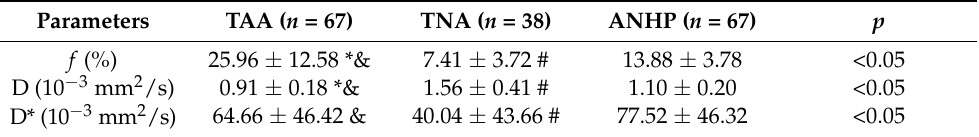
Table 4. The parameter values of different tissues and their